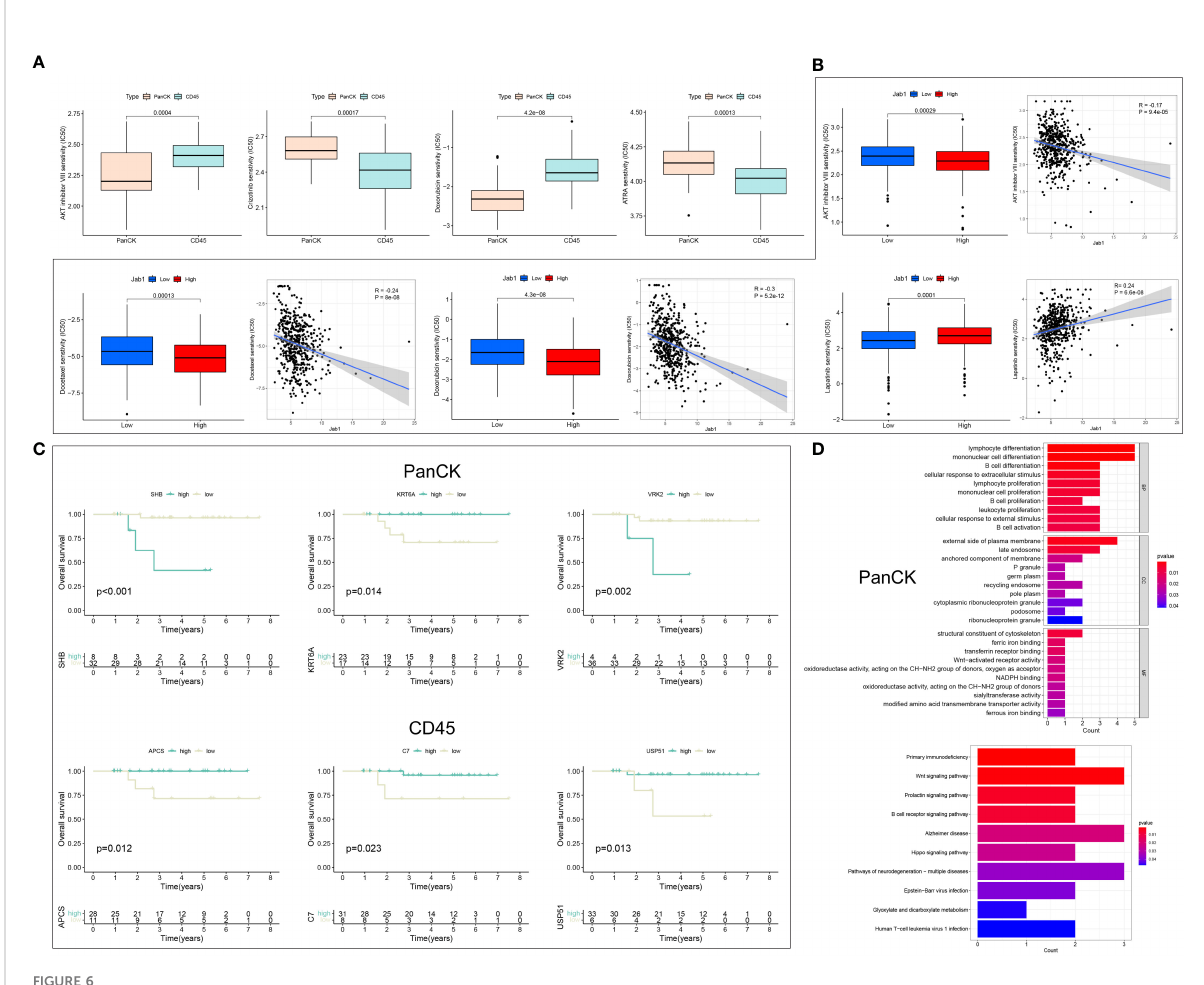
FIGURE 6 Drug sensitivity analysis and the role of Jab1 in different regions of NPC. (A) Differences in IC50 of drugs in NPC patients in tumor cell enriched regions and immune cell enriched regions. (B) Jab1 expression affects the IC50 of drug-treated HNSCC patients. (C) Differential genes from the Jab1 high and low expression groups for survival analysis in tumor cell enriched regions and immune cell enriched regions. (D) Differential genes from the Jab1 high and low expression groups for functional enrichment analysis (GO and KEGG) in tumor cell enriched